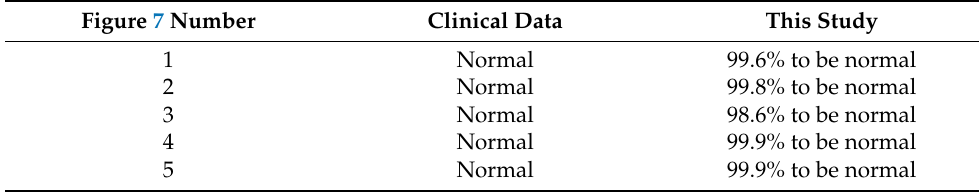
Figure 8. Outer example for validation (number 1 to 3 from left to right). Table 6. Result after judgement for Figure 8 sample image. Table 5. Result after judgement for Figure 7 sample